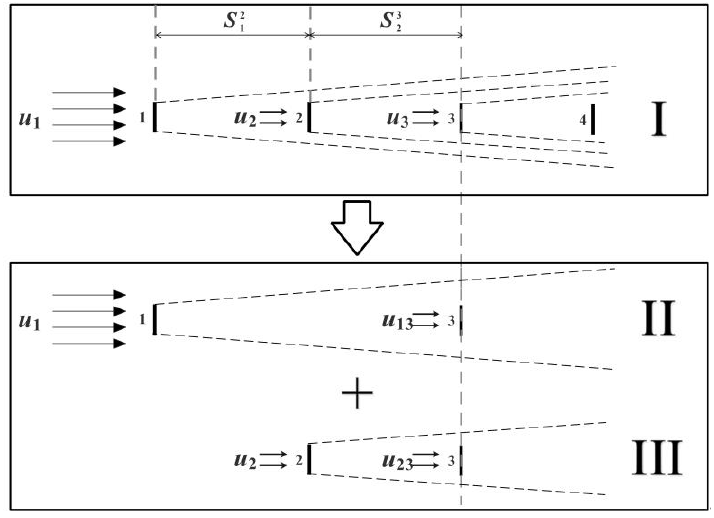
Figure 1. Schematic diagram of three overlapping turbine wakes. The simulation of the inflow velocity at turbine 3 in scenario I is decomposed into scenarios II and III, and then superimposed.